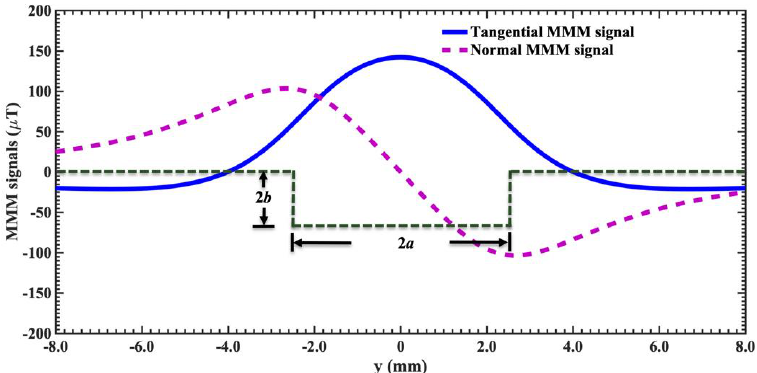
Figure 2. Variation of the normal ( Hy ) and tangential ( Hz ) metal magnetic memory (MMM) signals for a rectangular defect of a ferromagnetic sample with magnetic charge density ± S m .